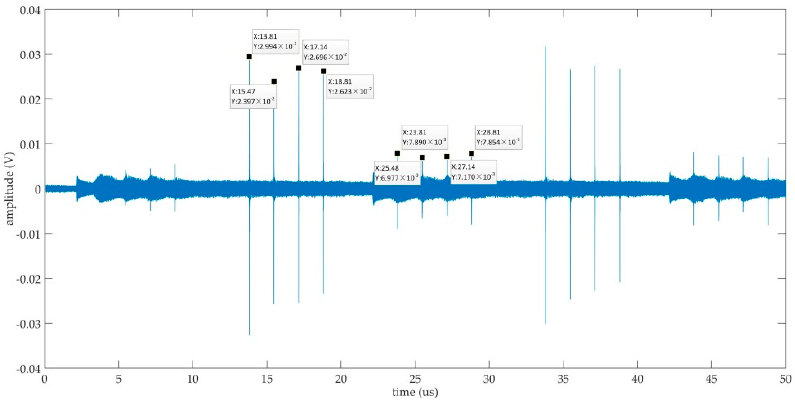
Figure 12. Output pulses of the FCS M-C arrangement.